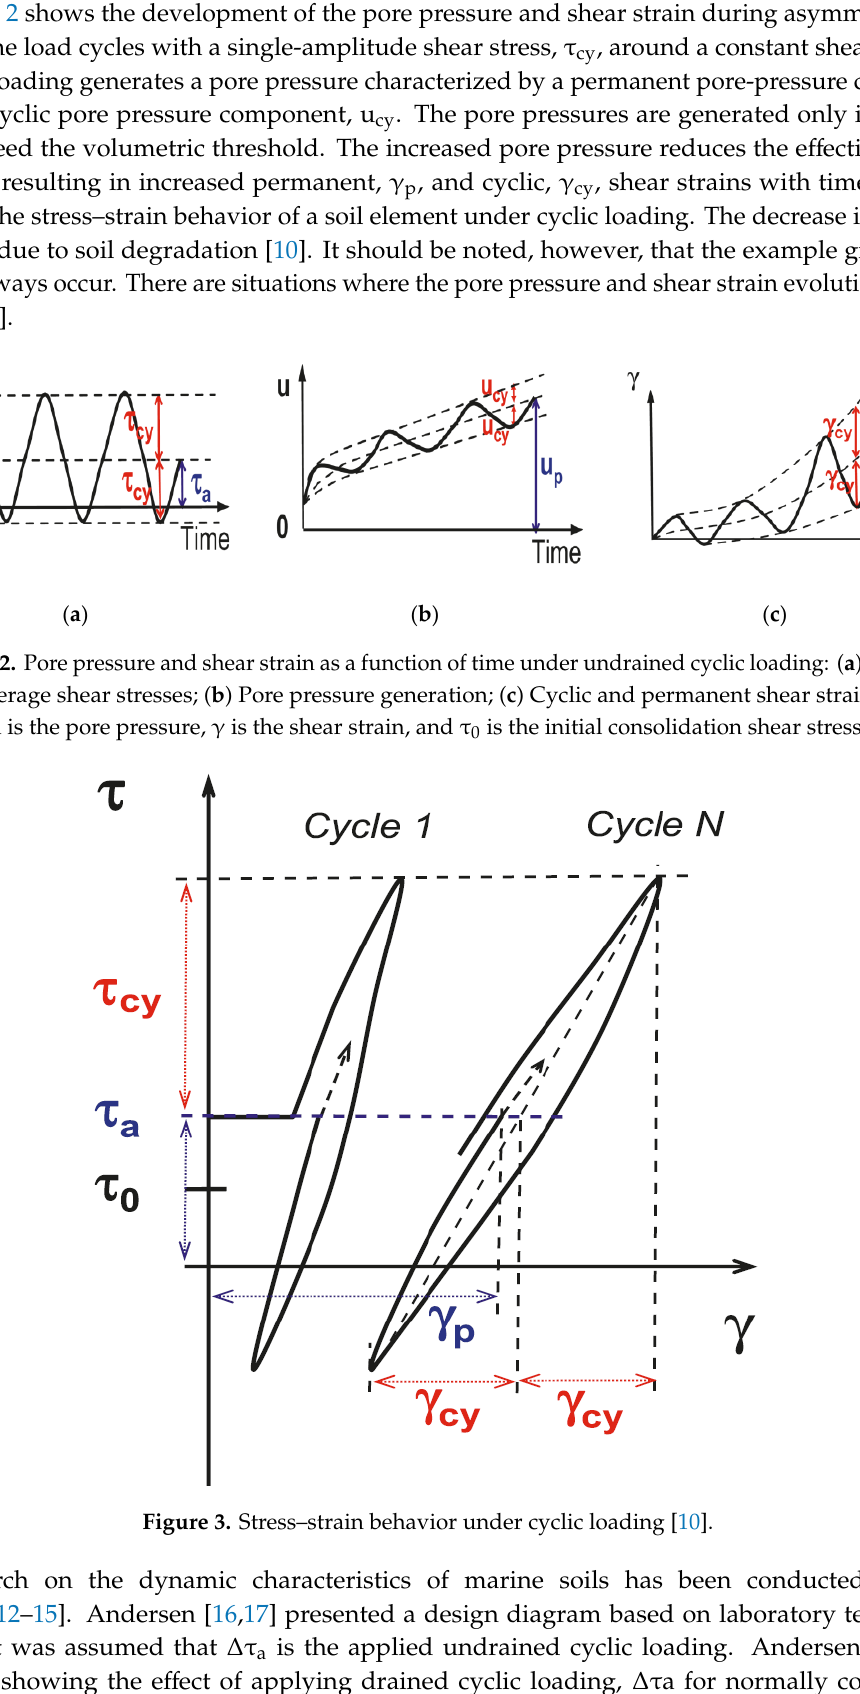
Figure 1. Modes of cyclic loading: ( a ) two-way, τ a = 0 (symmetric); ( b ) two-way, τ a > 0 (asymmetric); ( c ) one-way, τ a = τ cy ; ( d ) one-way, τ a > τ cy [1].